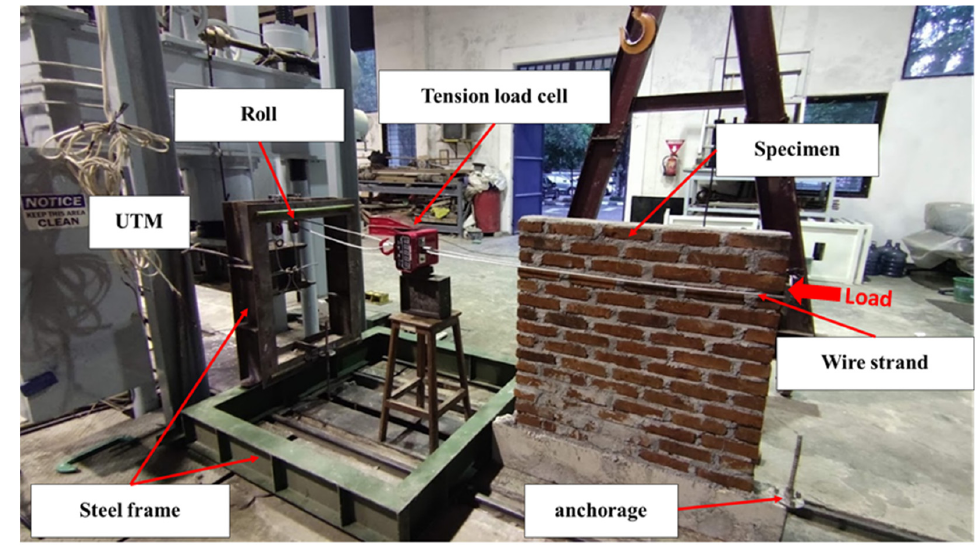
Figure 13. Pushover shear test on the masonry wall.